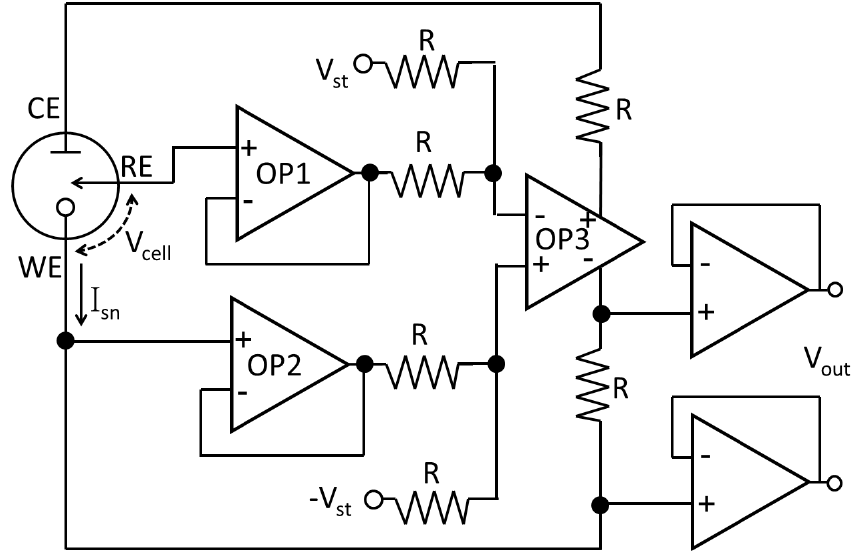
Figure 6. Fully-differential potentiostat (adapted from [46]). OP1–3 are operational amplifiers.